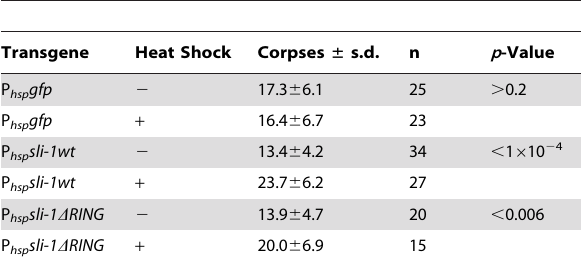
Table 4. Losses of sli-1 and abl-1 enhance each other’s suppression of some engulfment gene